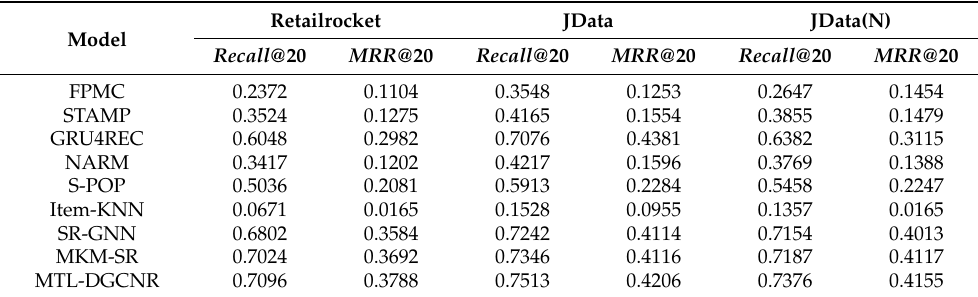
Table 2. Evaluation index values for ten models on three